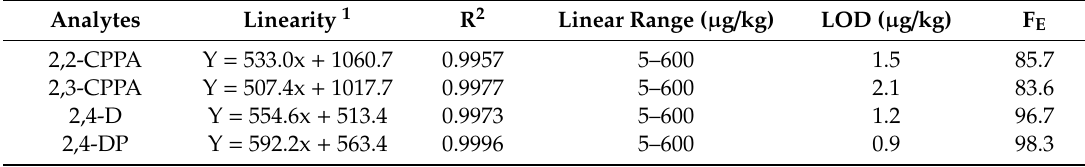
Table 1. Linearity, linear range, R 2 , LOD and F E of analytes in the samples of rice grains. Analytes